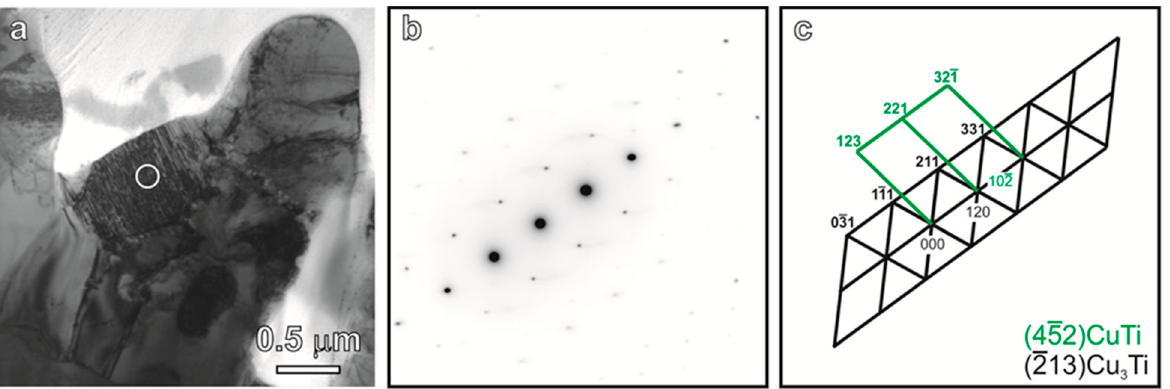
Figure 4. TEM images of the surface layer of the copper alloy treated by titanium ions (6 min): general views of the cross-section of the modified surface ( a ), microdiffraction patterns and schemes of their indexing ( b , c ).